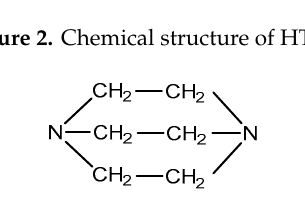
Figure 3. Chemical structure of DABCO.